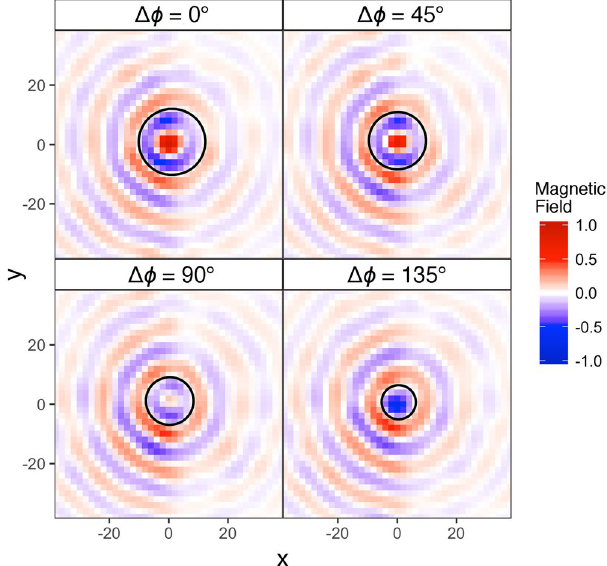
Figure 5. Measured instantaneous magnetic field (H z , arbitrary scale) at a height of 0.5 mm above the metasurface. The surface mode is excited at the centre of the image. The complex field is advanced in phase from 0 to 135° and the phase fronts (e.g. the null in electric field marked by the black circle) propagate towards the source (negative phase velocity) whilst, for our measurement system, power must flow away from the source (positive group